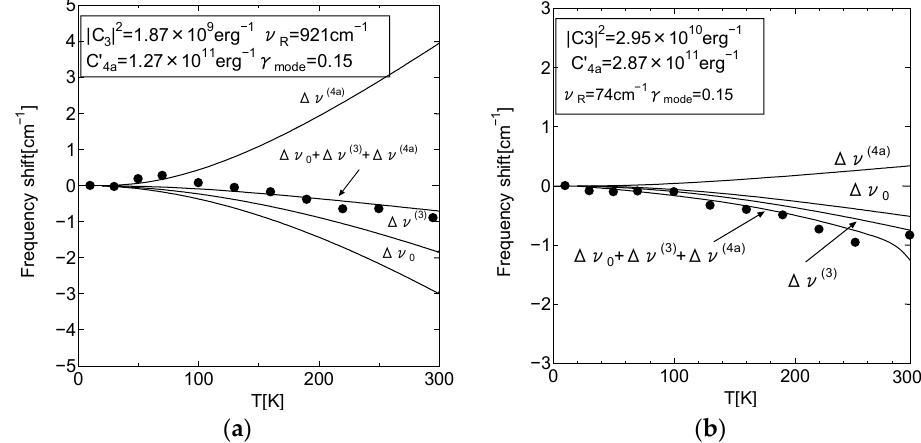
Figure 4. Temperature dependence of the frequency shift of the ( a ) internal A g ( ν 1 ) and the ( b ) external B g ( ν ext ) modes in SrWO 4 crystal. The experimental data are presented by filled circles, while the calculated dependences are presented by solid lines.